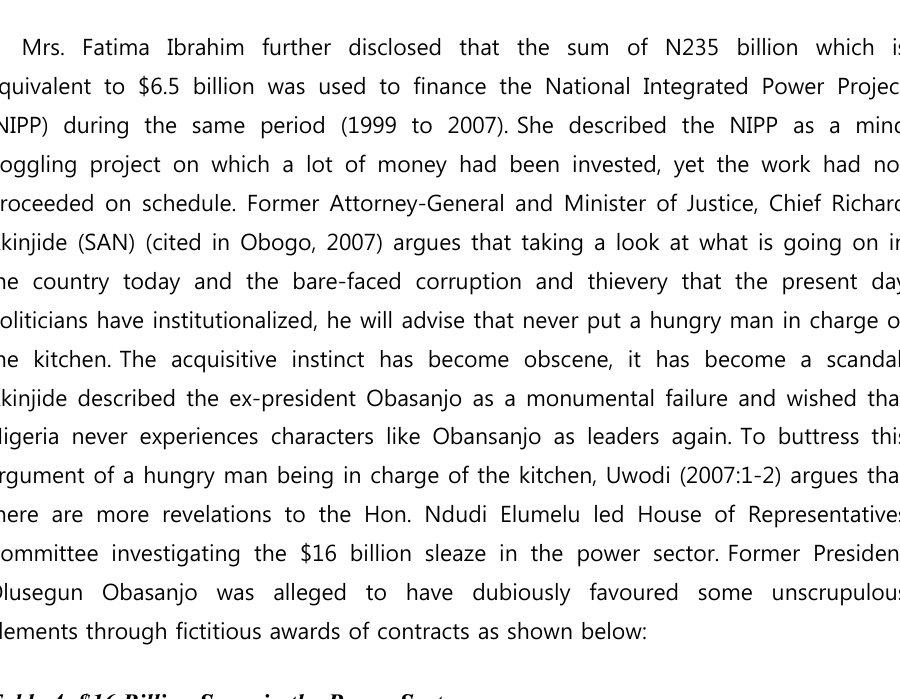
Table 4: $16 Billion Scam in the Power Sector Name of